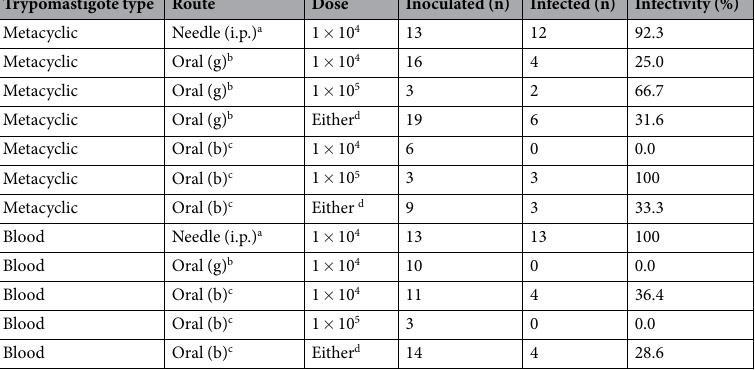
Table 1. Infectivity of Trypansoma cruzi in mice by oral routes. a Intra-peritoneal; b intra-gastric gavage; c buccal administration; d 1 × 10 4 and 1 × 10 5 data